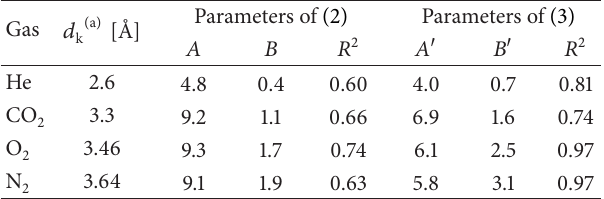
Table 1: Parameters of (2) and (3) obtained from linear regression of the experimental